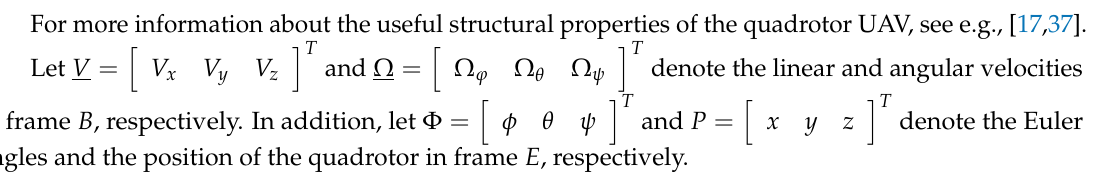
Figure 1. A schematic representation of the quadrotor unmanned aerial vehicle (UAV).